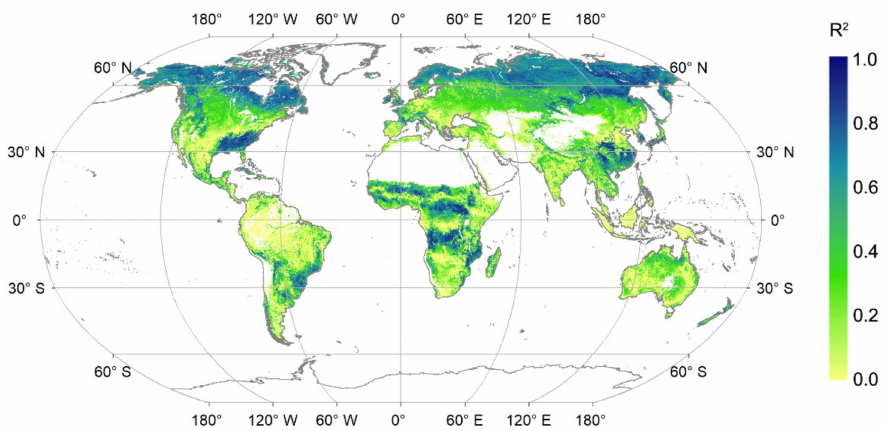
Figure 8. Spatial distribution of the coefficients of determination. The pixels with no data are colored grey.